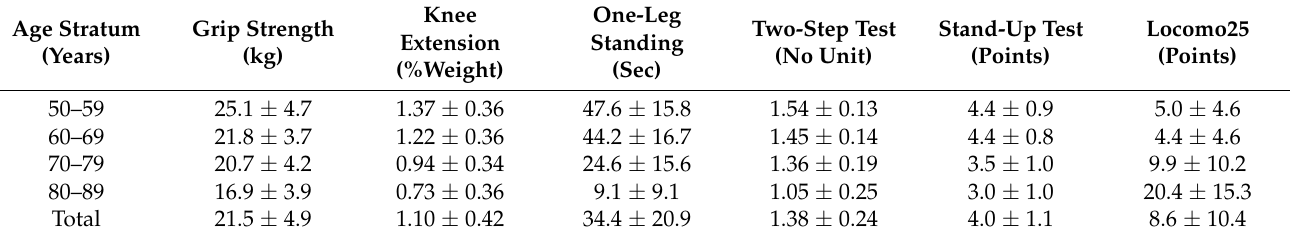
Table 3. Results of physical performance tests by age